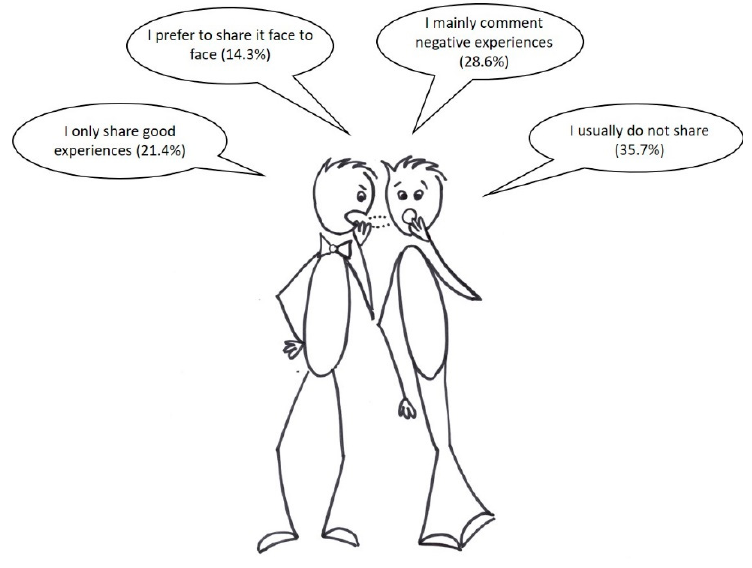
Figure 3. Sharing previous purchasing experiences on social media .